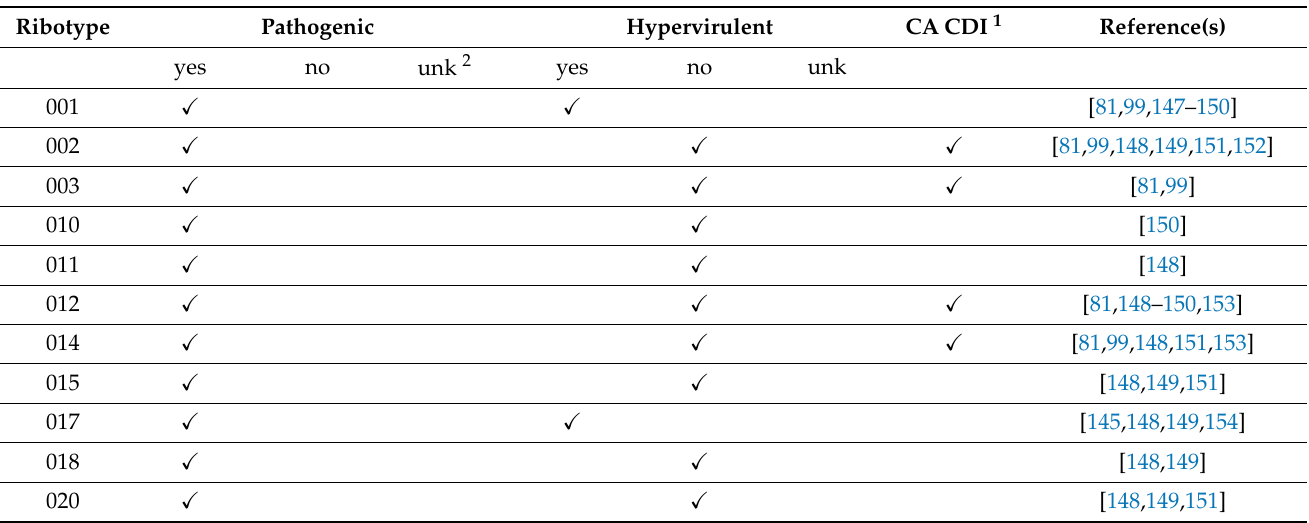
Table 4. Further characterisation (pathogenicity, hypervirulence and association with community- acquired CDI) of the ribotypes isolated from foods (Tables 2 and